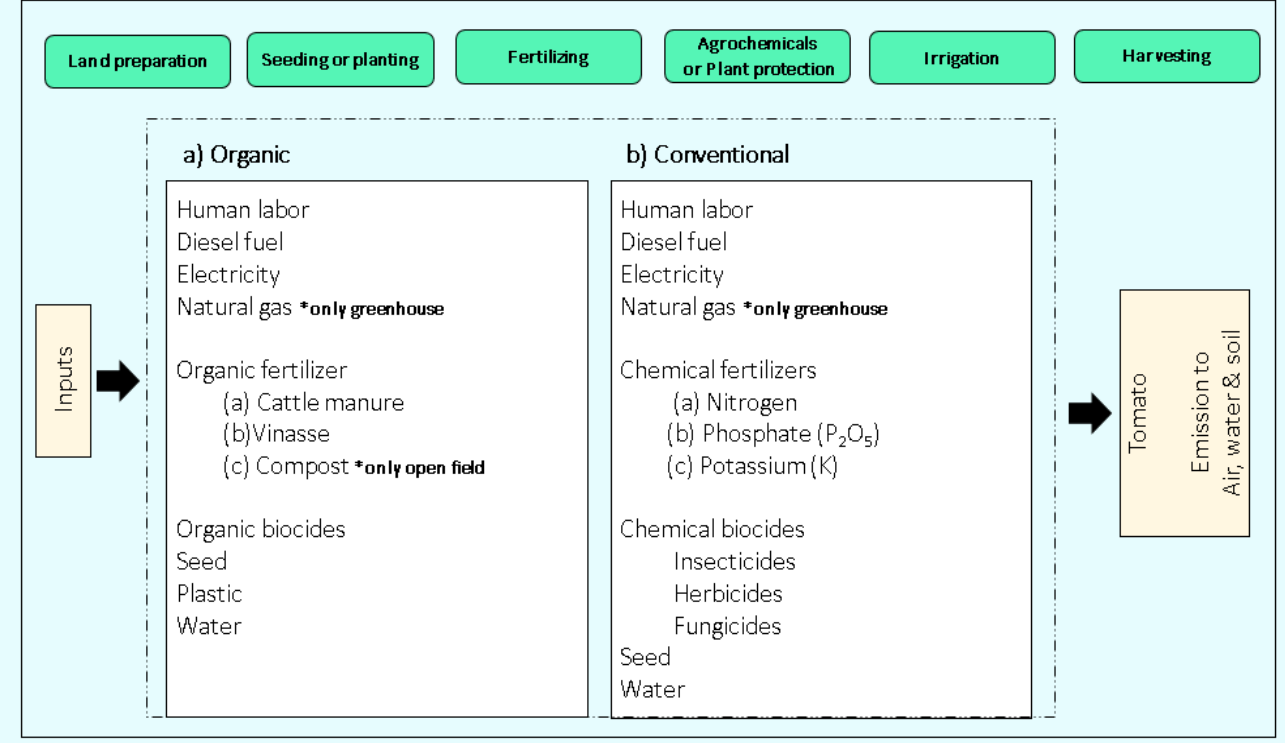
Figure 1. System boundaries of organic ( a ) and conventional ( b ) tomato cultivation in the greenhouse and open field.